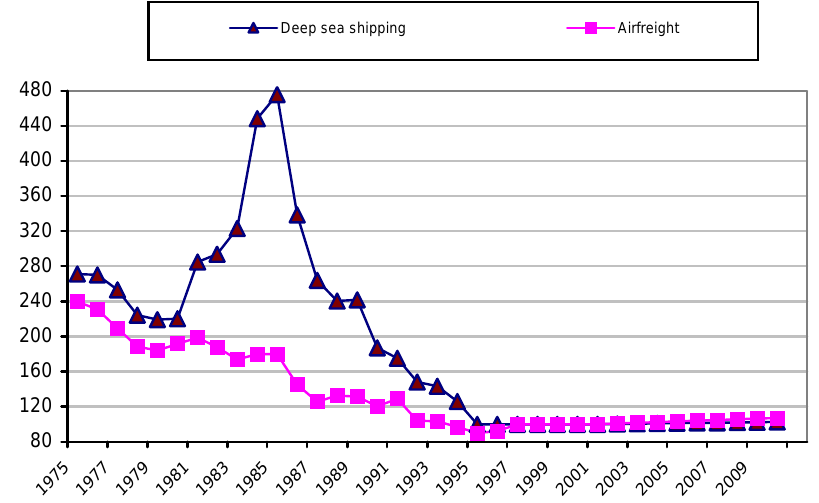
Figure 3. Historical and expected trends in freight rates (intercontinental transport) in indices (2001 = 100)